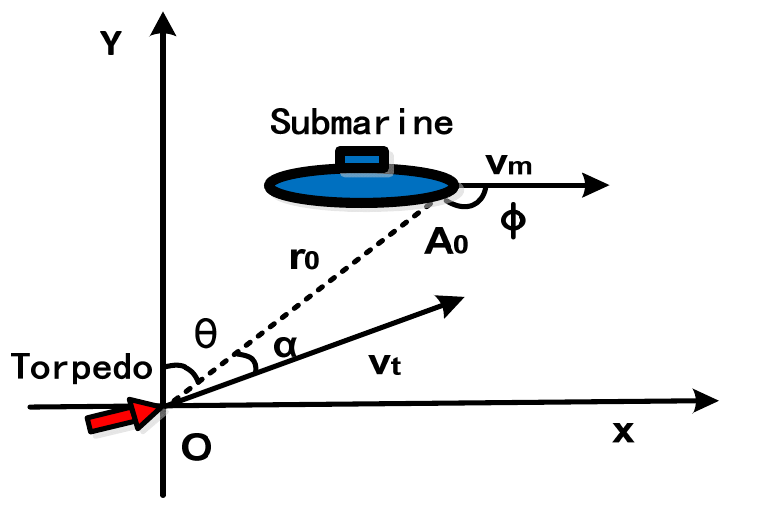
Figure 10. The torpedo and the target movement posture.